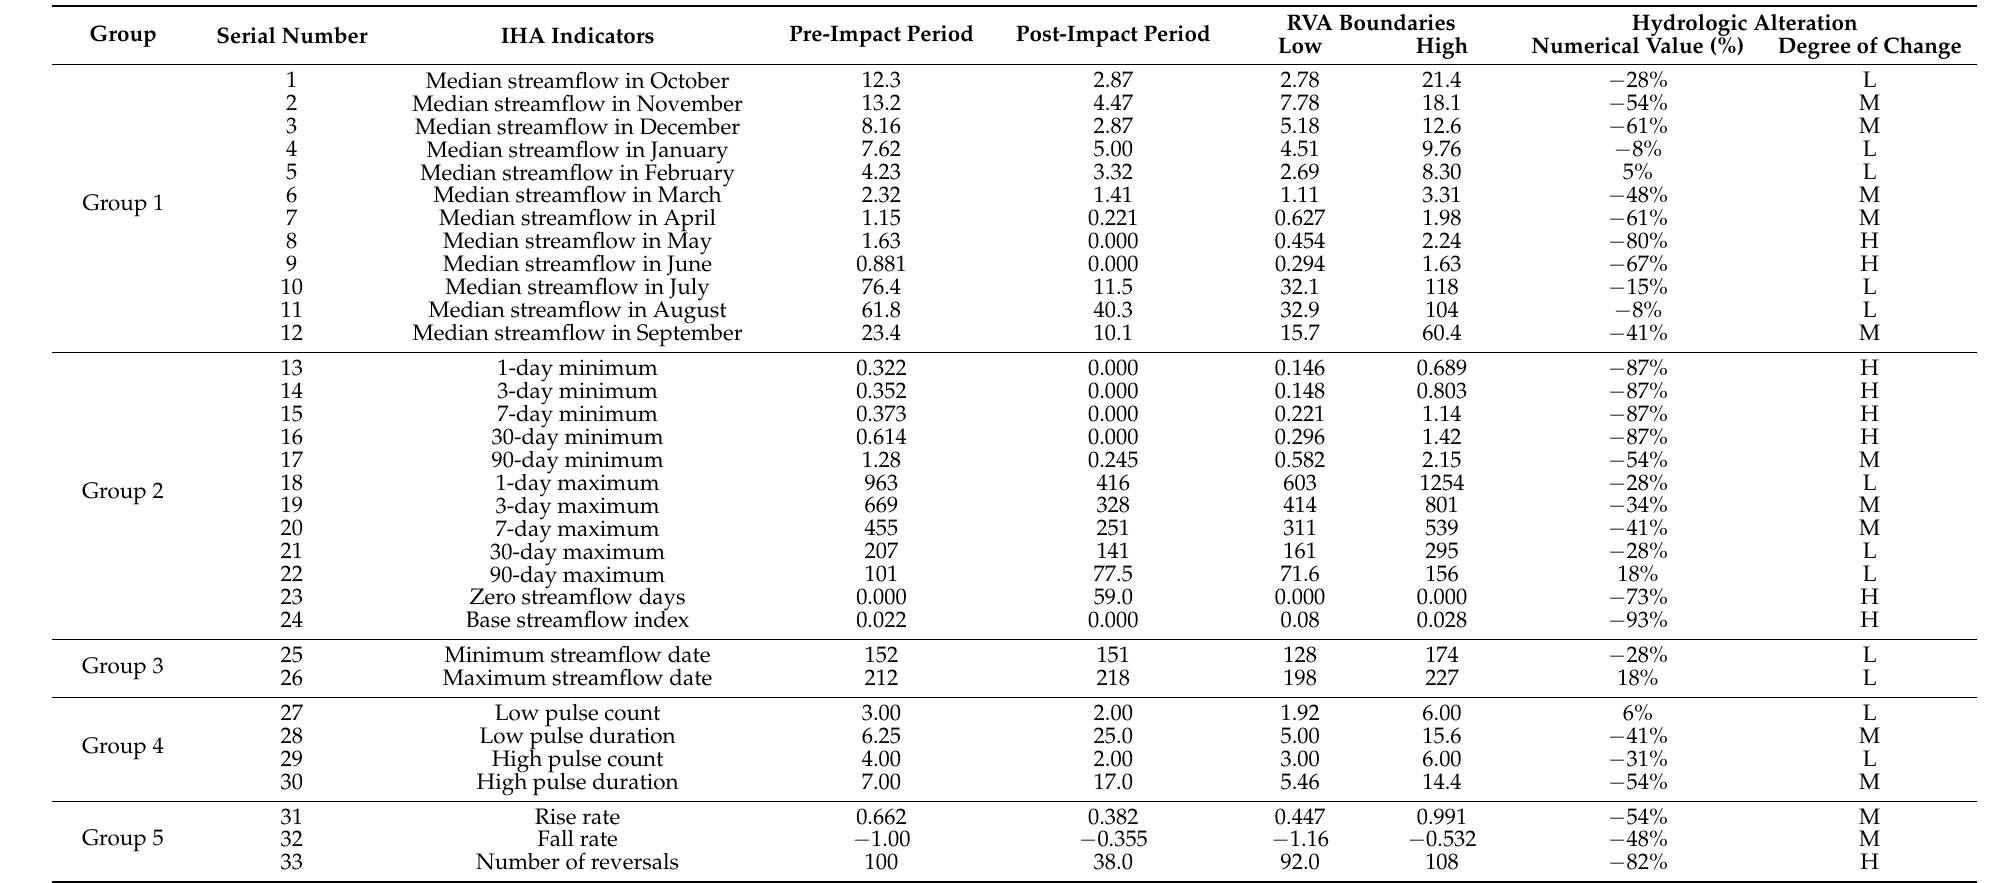
Table 3. Changes of hydrological indicators in the